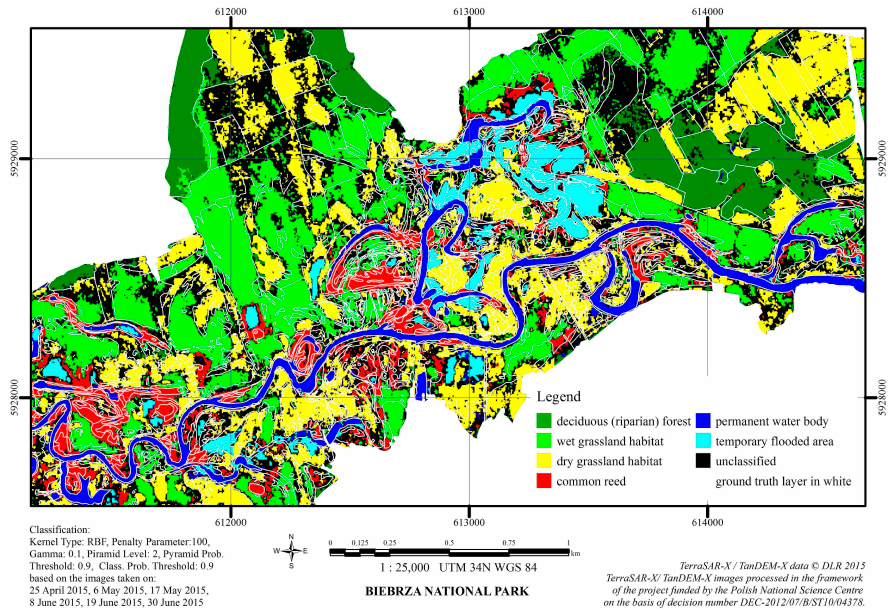
Figure 13. A classification map of the Area of Interest AoI obtained using sigma nought and coherence time series of TSX/TDX data (four polarizations). This configuration achieved the best classification accuracy (OAA = 83%, KIA = 0.80).